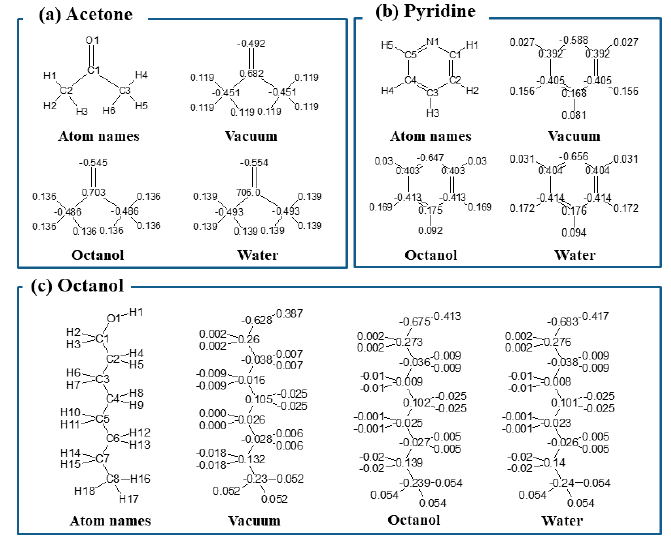
Figure 2. Calculated atomic charges of (a) Acetone, (b) Pyridine, and (c) Octanol in vacuum, octanol, and water.